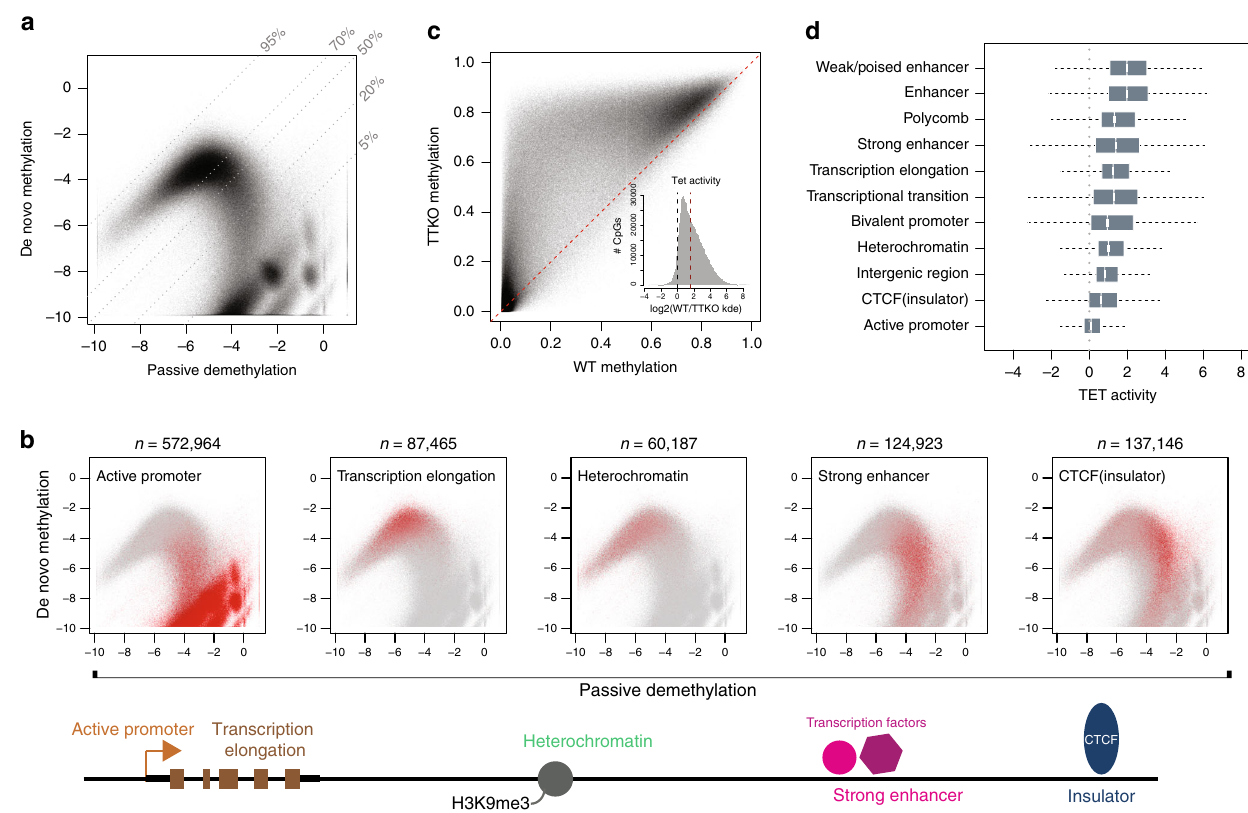
Fig. 4 Rate combinations are characteristic of particular genomic contexts. a Scatterplot of k de and k me for all cytosines. Dashed lines represent different steady-state methylation levels, which are noted on the right upper borders. b Scatterplots as in a , but with CpGs colored according to overlap with previous genome annotations 52,54 . Red points represent CpGs of interest for the particular genomic annotation. For example, in the fi rst panel all CpGs overlapping with promoter regions are shown in red, while all CpGs outside of promoters are shown in gray. The number of CpGs overlapping with each state are noted above the respective panel. A graphical depiction of the genomic annotations for the fi ve different contexts is shown below the scatterplots. c Scatterplot of methylation levels measured in wild-type ( x -axis) and TTKO cells ( y -axis). Inset: change in k de as a function of TET activity. Values on the x - axis represent log2( k de WT ) − log2( k de TTKO ). The vertical blue line represents CpGs where TET activity has no effect on k de , while the red vertical line represents a three-fold increase in the demethylation rate as a function of TET activity. Note the almost unimodal shift in steady-state methylation levels underscoring the role of TET proteins as demethylases. d TET mediated changes in k de as a function of genomic context. TET activity is as de fi ned above in c . Annotated regions are sorted based on mean change in k de . The box represents the middle 50% of the data, the line inside the box is the median, and whiskers are de fi ned by the most extreme values lying within 1.5 times the interquartile